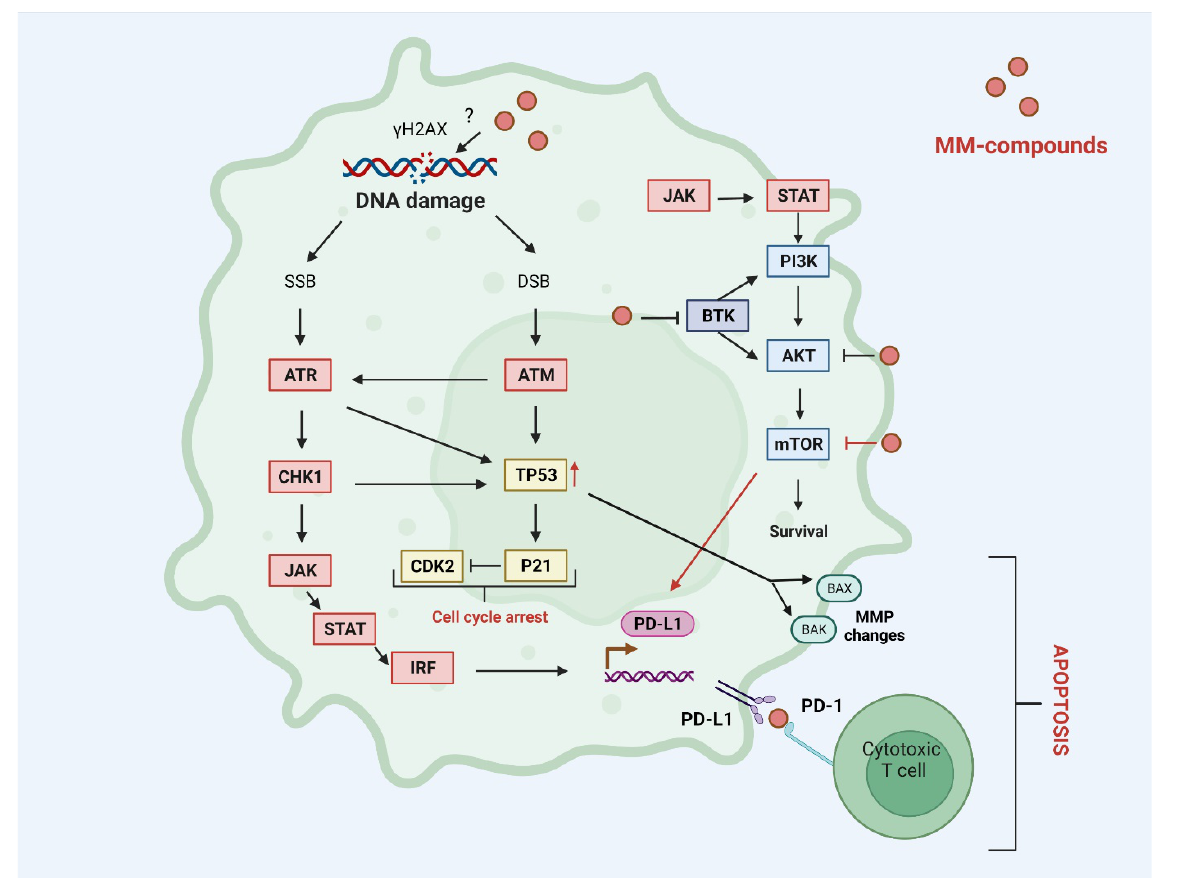
Figure 2. Predicted mechanism of action of MM compounds: MM compounds may act as BTK, PI3K-AKT-mTOR, and PD-L1 inhibitors that reduce cell survival and trigger apoptosis in a cytotoxic T-cell-dependent mechanism. Inhibition of mTOR kinase leads to up-regulation of PD-L1 expression. Increased expression of PD-L1 may result from the accumulation of DNA damage and activation of ATM/ATR/CHK1 and JAK/STAT/IRF signaling pathways. DNA damage leads to the up-regulation of TP53 tumor suppressor and induction of pro-apoptotic proteins including BAK and BAX involved in the intrinsic apoptosis pathway associated with MMP changes and increased production of P21 that works as an inhibitor of CDK2. AKT—RAC-alpha serine/threonine-protein kinase; ATM/ATR—serine-protein kinase ATM/ATR; BAX/BAK—pro-apoptotic protein BAX/BAK; BTK—tyrosine-protein kinase BTK; CDK2—cyclin-dependent kinase 2; CHK1—serine/threonine- protein kinase CHK1; DSB—double-strand break; IRF1—interferon regulatory factor 1; JAK—tyrosine- protein kinase JAK; MMP—mitochondrial membrane potential; mTOR—serine/threonine-protein kinase mTOR; PI3K—phosphatidylinositol-4,5-bisphosphate 3-kinase; PD-L1—programmed cell death 1 ligand 1; RTK—receptor tyrosine kinase; STAT—signal transducer and activator of transcrip- tion; TP53—cellular tumor antigen p53; γ H2AX—phosphorylated histone protein